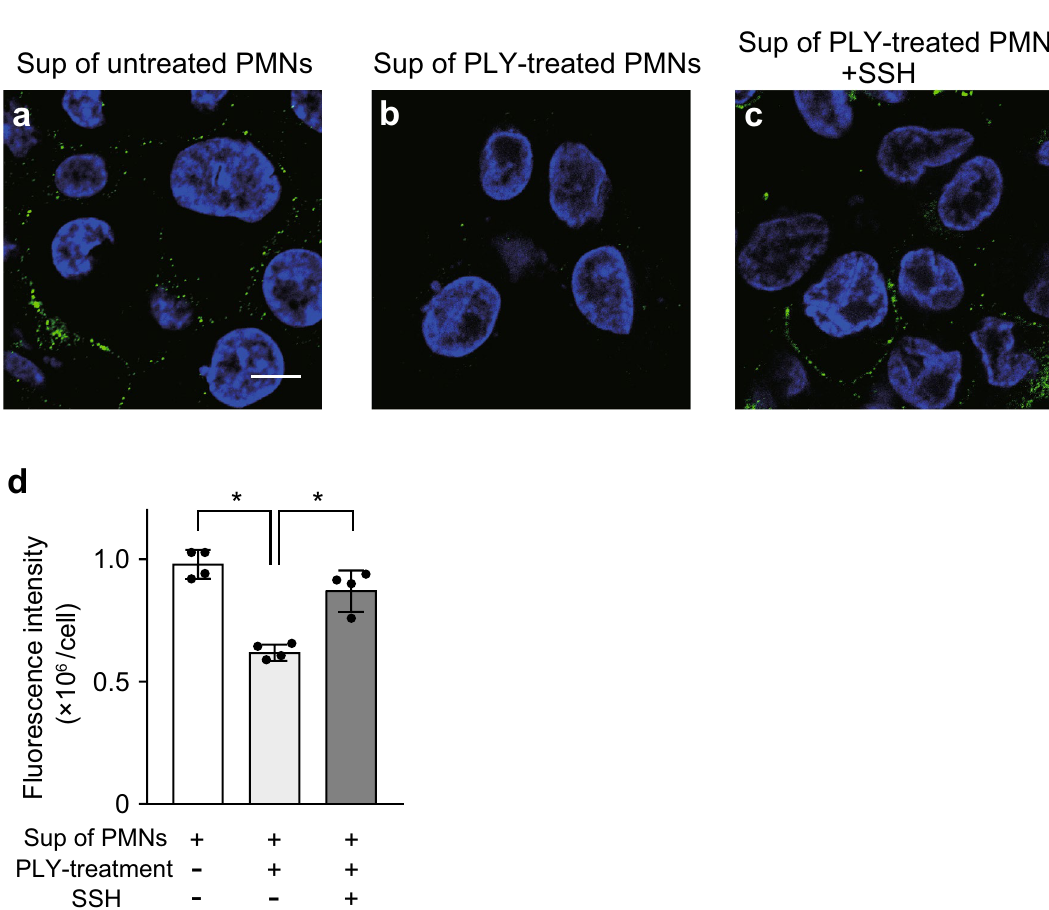
Figure 1. Culture supernatant from neutrophils treated with pore-forming toxin decreases fluorescence intensity of HLA class II on macrophages. ( a – c ) THP-1-derived macrophages were exposed to culture supernatant (Sup) from untreated neutrophils (PMNs) or pneumolysin (PLY)-treated PMNs in the presence or absence of 100 μg/mL sivelestat sodium hydrate (neutrophil elastase inhibitor; SSH) for 6 h. Representative fluorescence microscopy images of macrophages stained for DNA (DAPI; blue) and HLA class II (HLA-DP β1; green) are shown. Scale bar: 10 µm. ( d ) Fluorescence intensity of HLA class II per cell was calculated. Data representing the mean ± SD of quadruplicate experiments was evaluated by one-way analysis of variance with Tukey’s multiple-comparisons test. *Significantly different between the indicated groups at P <